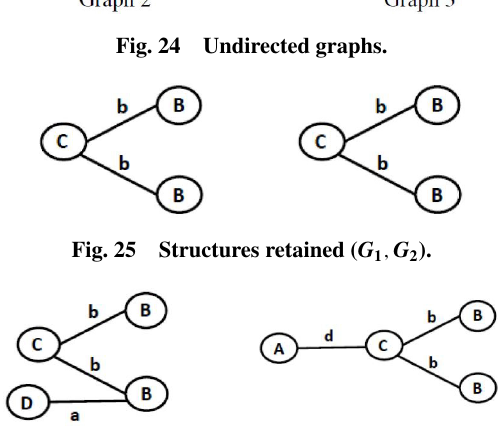
Fig. 24 Undirected graphs.